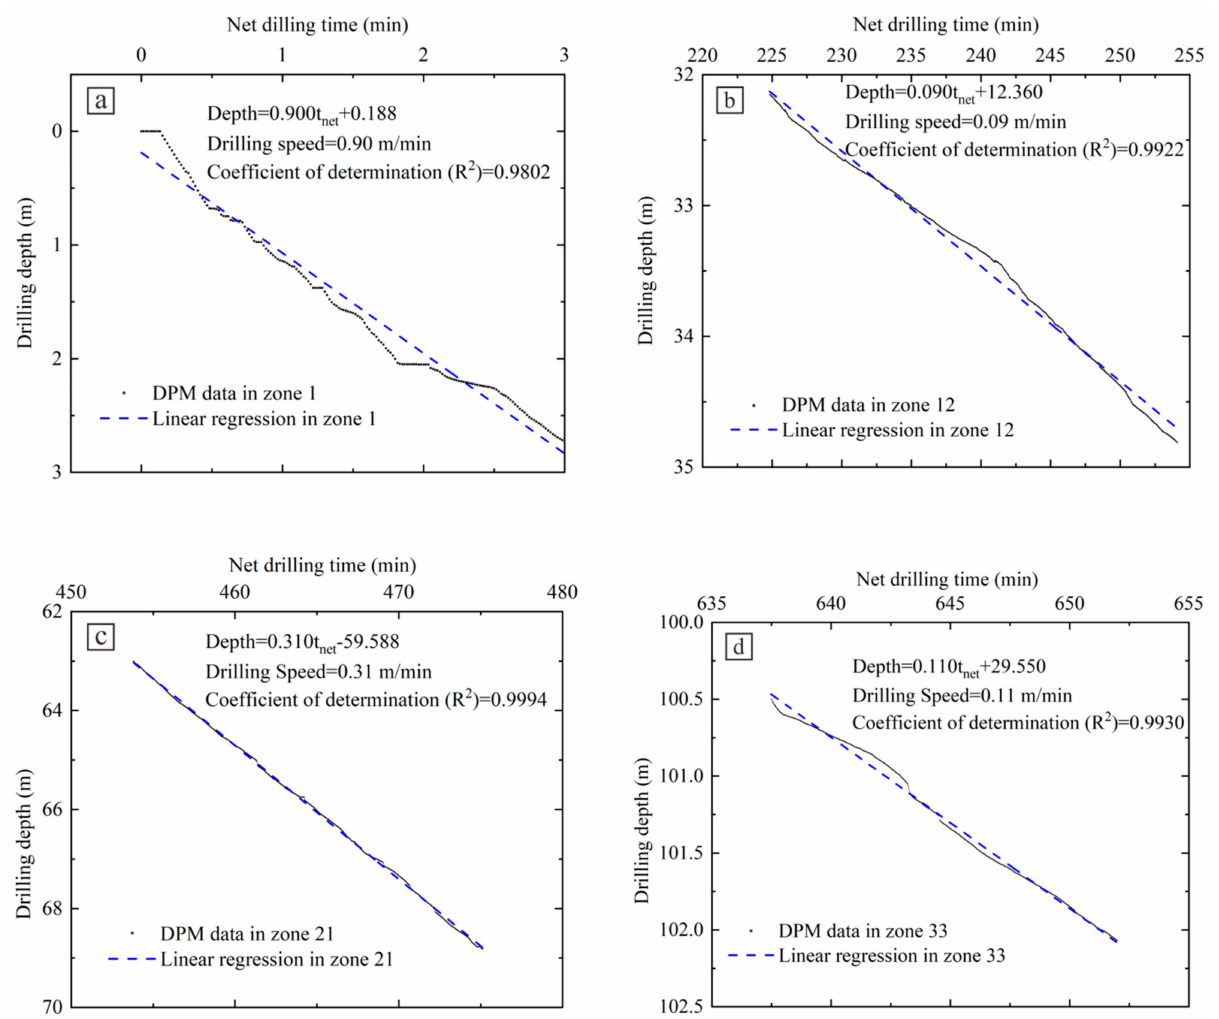
Figure 10. ( a – d ) Linear regression results of drilling depth and drilling time in some subzones of the borehole in Yan’an